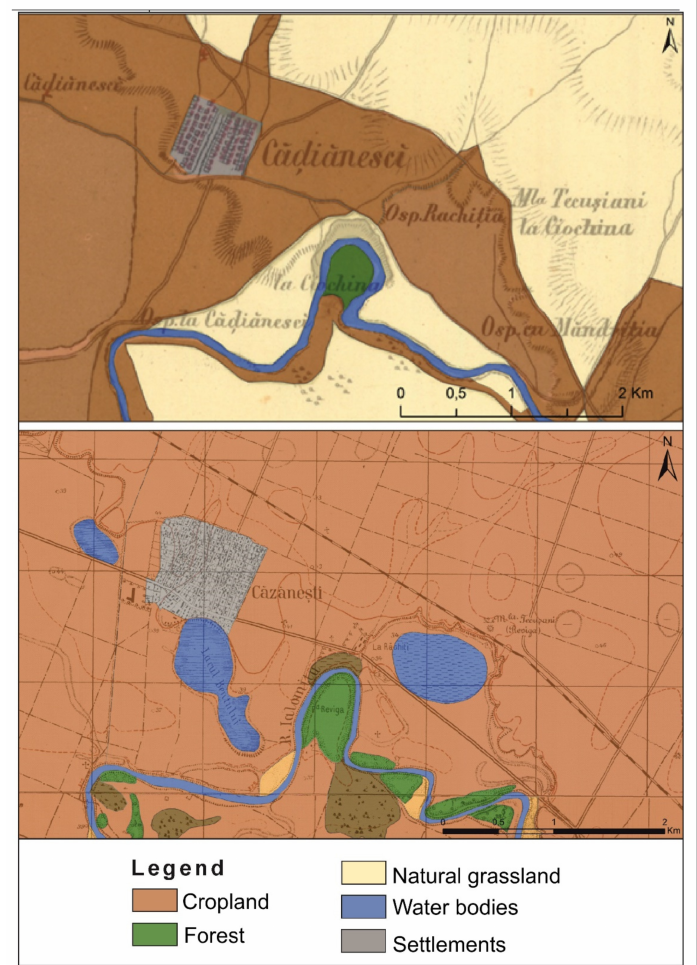
Figure 4. The extension of agricultural land in the proximity of C ă z ă nes beginning of the 20th